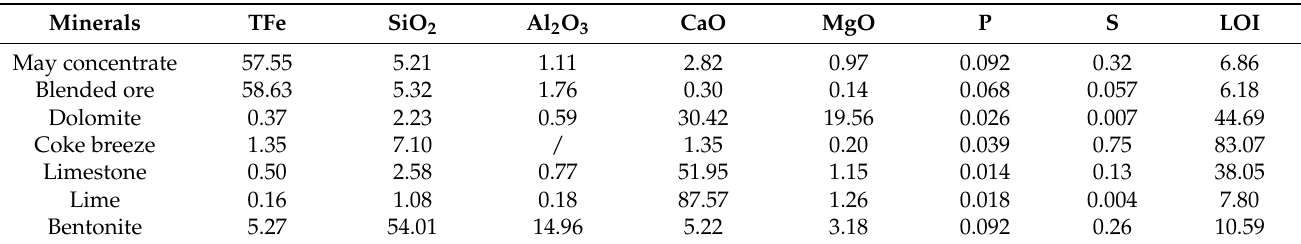
Table 1. Chemical compositions of raw materials (wt.%).